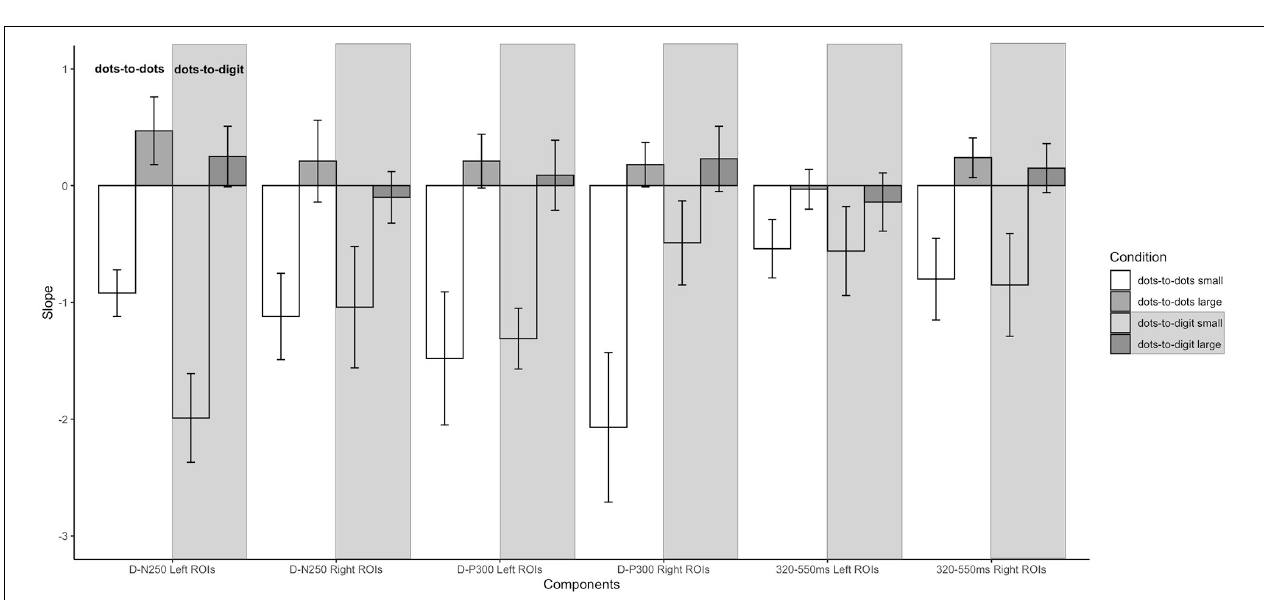
FIGURE 4 | Mean amplitude results and topographical maps. Top row: mean amplitude for each sample numerosity in the two separate conditions for components (A) D-N250 on left ROIs and (B) D-P300 on both left and right ROIs. Error bars represent the standard error of the mean. Bottom row: topography for each sample numerosity in the two conditions for components (C) D-N250 and (D) D-P300. The maps were obtained from 220 to 270 ms for D-N250 and 270 to 320 ms for D-P300.